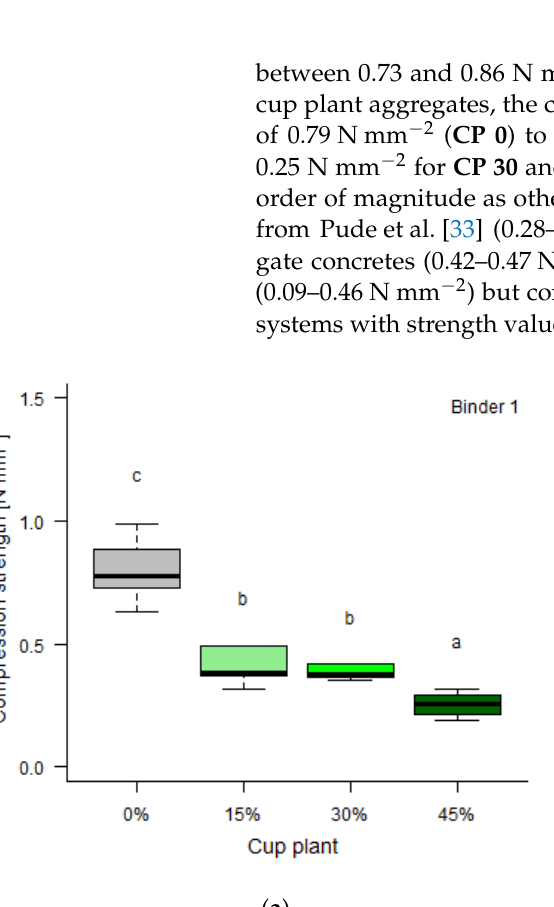
Table 5. Density values of the compression prim samples for both binder systems at the light ag-